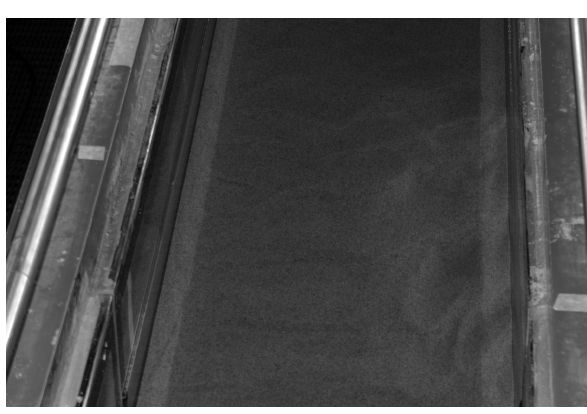
Figure 2: Flume used in the experiments